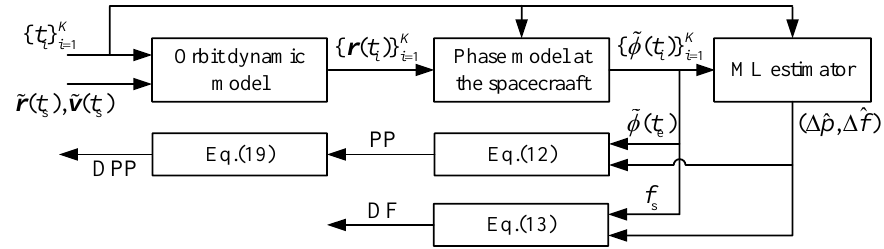
Figure 1. Flowchart of navigation measurements estimation.